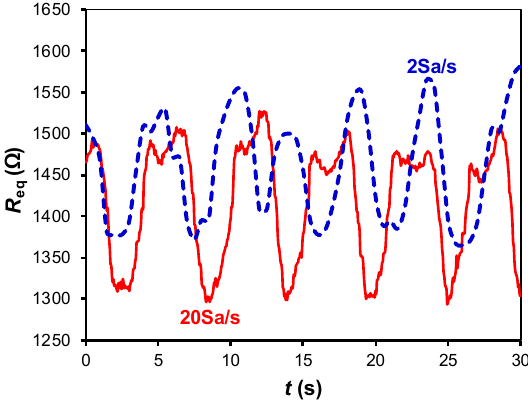
Figure 7. Small-signal resistance variations monitored by the DIC in Figure 2a for different sampling frequencies. The test was carried with subject S3 in the sitting posture P2, with C = 1 µF.